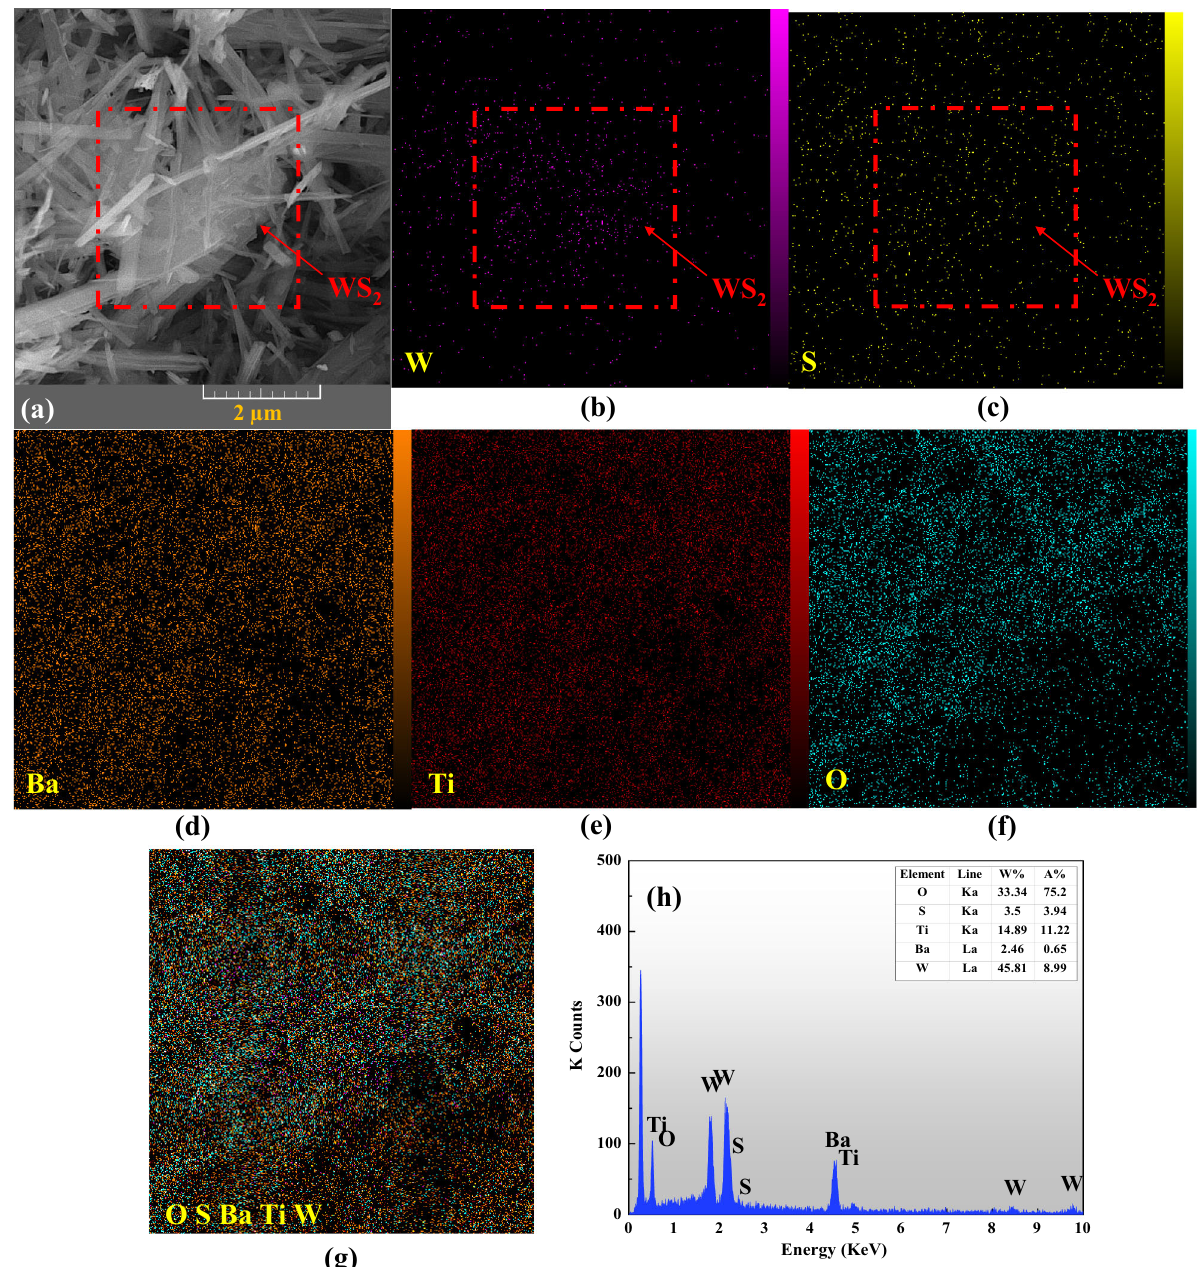
Fig. 3 Elemental mapping graphs of the BaTiO 3 /WS 2 composite. a The SEM image and b – g SEM elemental mapping of the BaTiO 3 /WS 2 composite. h The EDX spectra correspond to the composite (inserted Table: quantitative results obtained for W, S, O, Ba, and